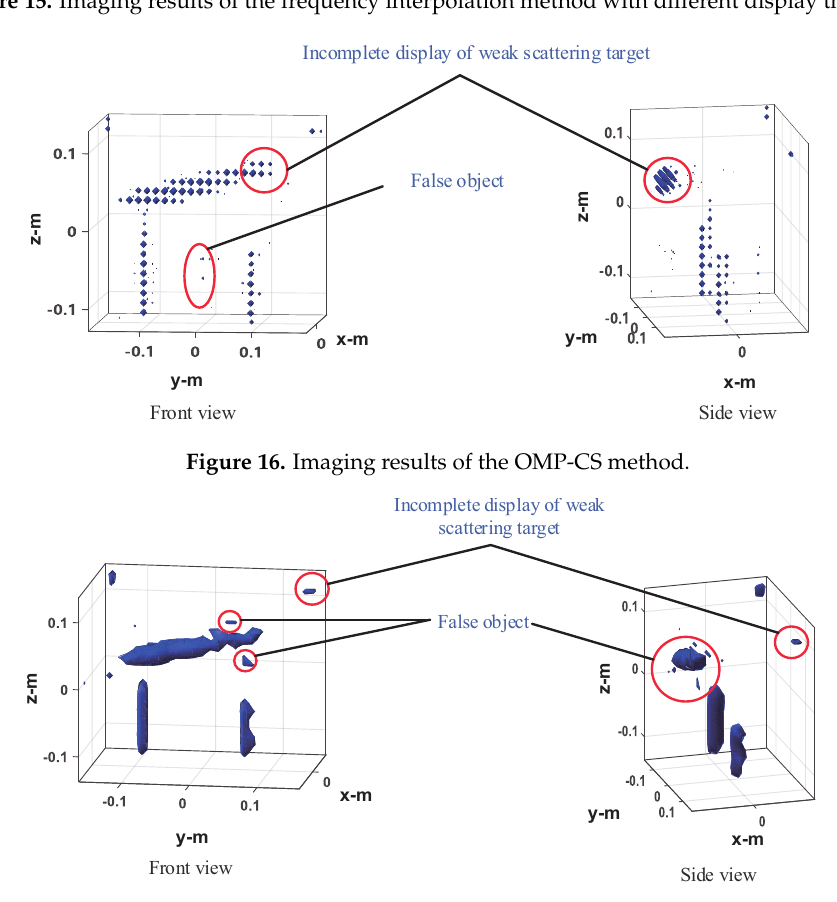
Figure 17. Imaging results of the (cid:96) 1 -TV-CS